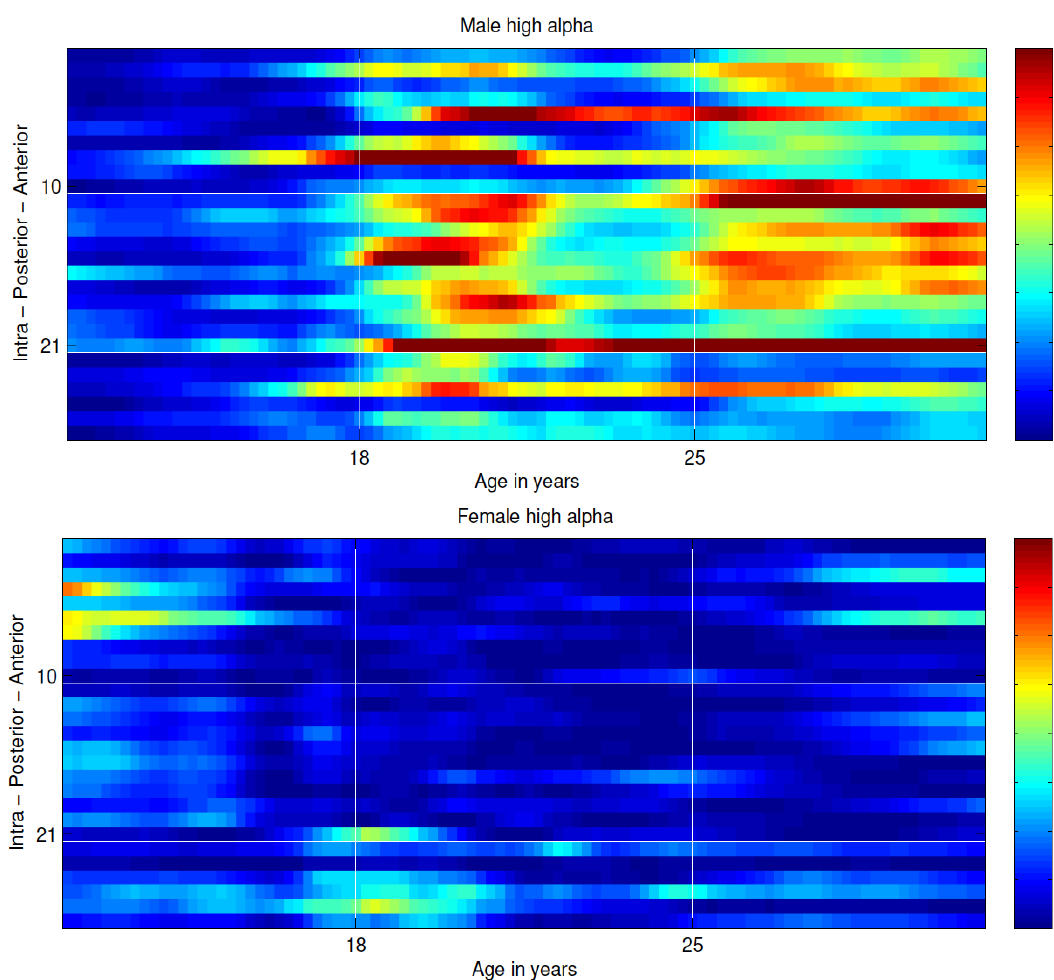
Figure 2. Association (−log10 p -value) of DSM-IV AD PRS ( p < 0.001 threshold) at coherence pairs ( y - axis) organized (top to bottom) from interhemispheric anterior pairs to posterior pairs, and intra-hemispheric pairs; prominent associations with fronto-central, tempo-parietal, centro-parietal, and parietal-occipital interhemispheric high alpha coherence are observed only among males from ages 18–31.